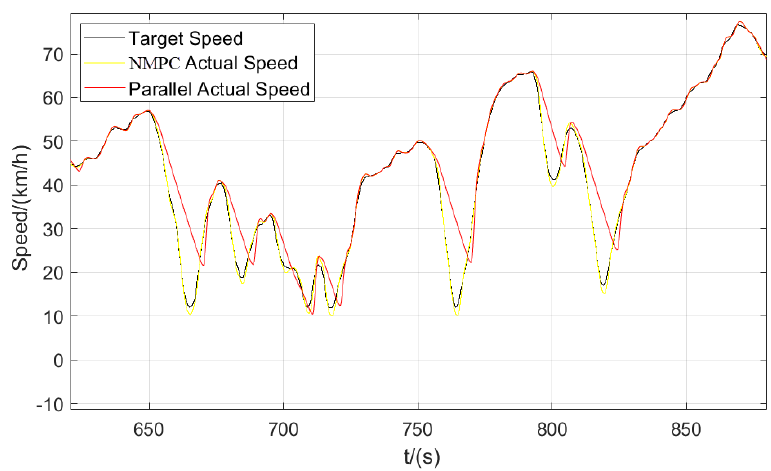
Figure 8. Target speed-time vs. actual speed-time (partially enlarged view).